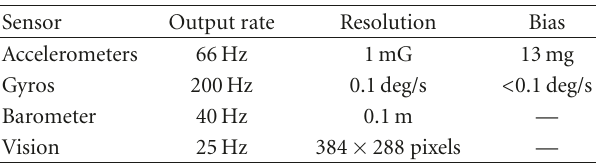
Table 1: Available characteristics of the sensor used in the naviga- tion